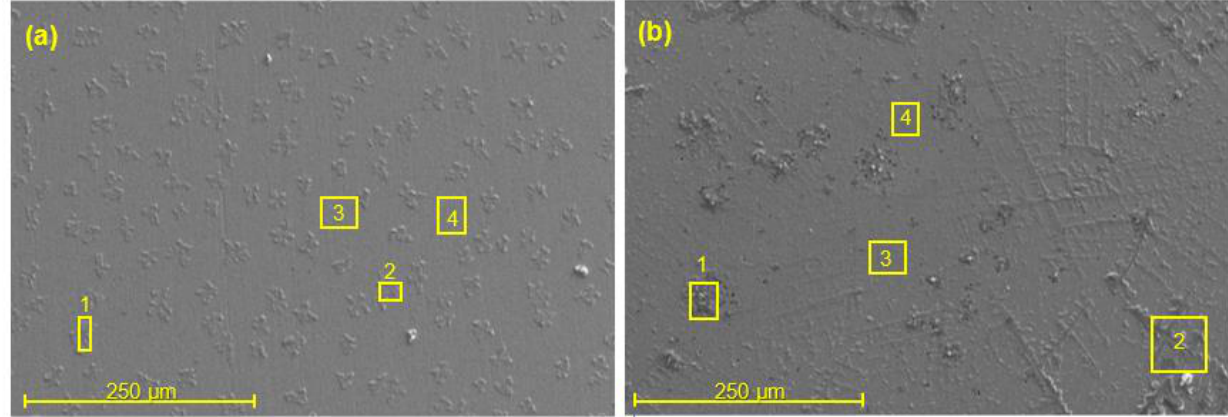
Figure 8. SEM image after impedance measurements for ( a ) AISI 304L and ( b ) AISI 316L in seawater with 40 ppm S 2− ions at 298 K with marked parts of EDS analysis (yellow numbers).